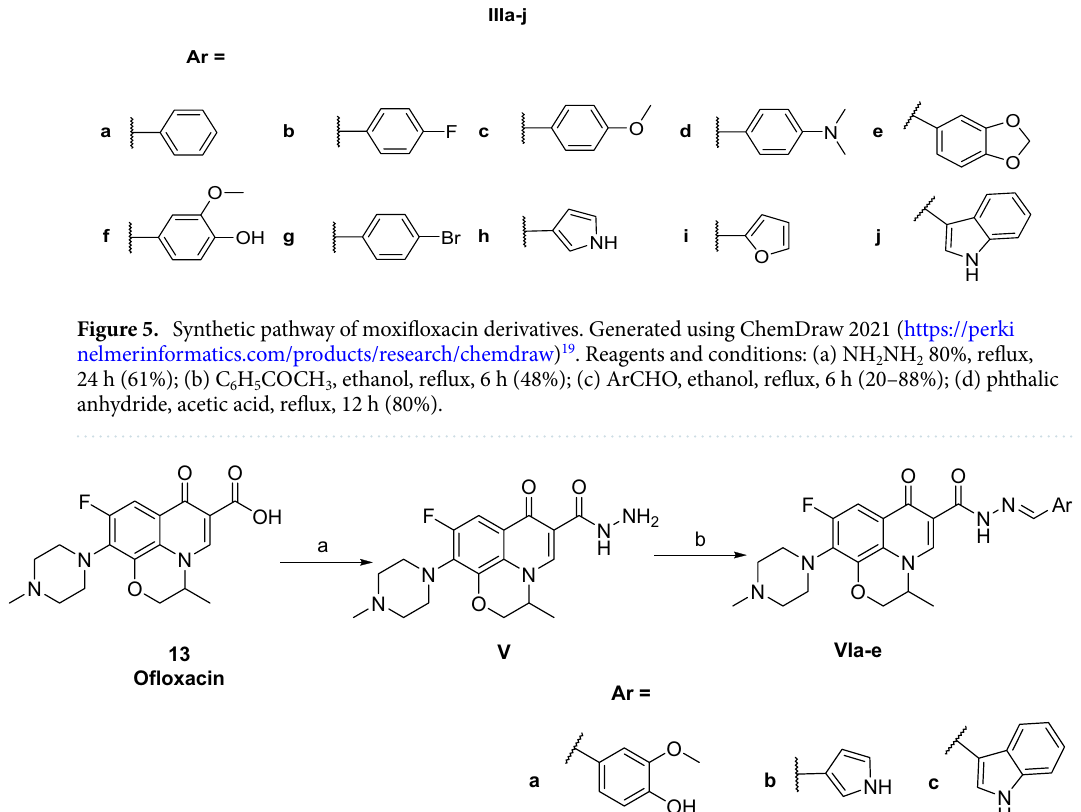
Figure 6. Synthetic pathway of ofloxacin derivatives. Generated using ChemDraw 2021 (https:// perki nelme rinfo rmati cs. com/ produ cts/ resea rch/ chemd raw) 19 . Reagents and conditions: (a) NH 2 NH 2 80%, reflux, 24 h (40%); (b) ArCHO, ethanol, reflux, 6 h